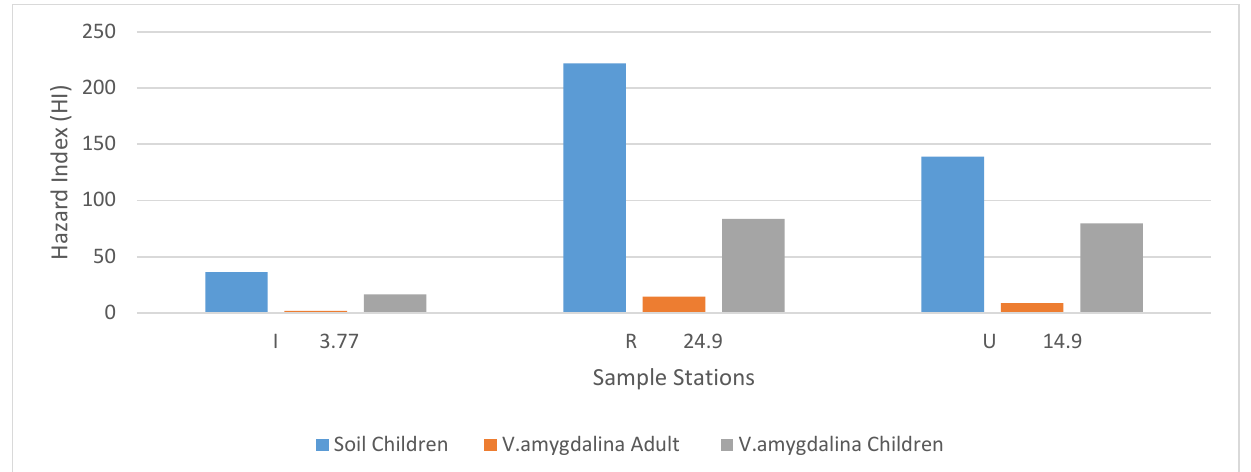
Figure 5. Spatial Hazard Index trend for both soil and Vernonia amygdalina.